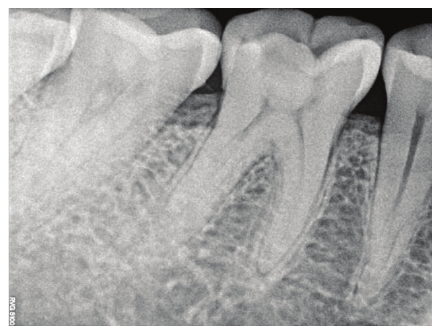
Figure 37: Preoperative RVG 36.